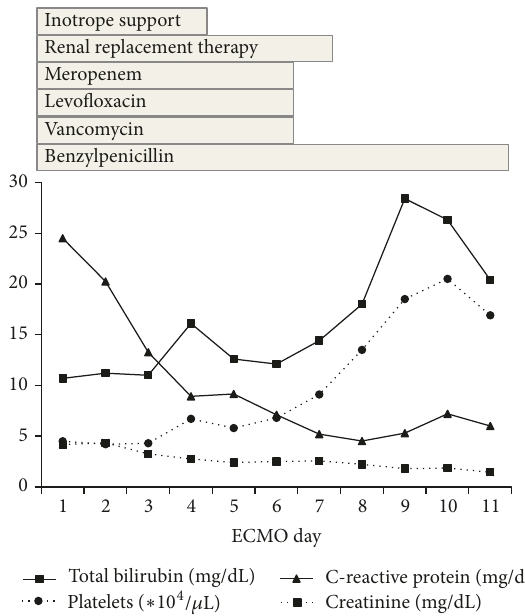
Figure 1: Summary of laboratory data and therapeutic